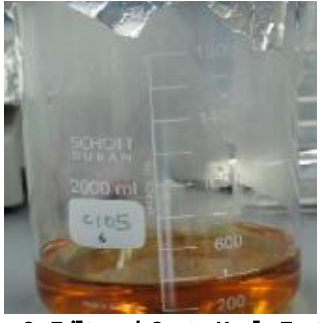
Figure 3. Filtered Gotu Kola Extracts Solution